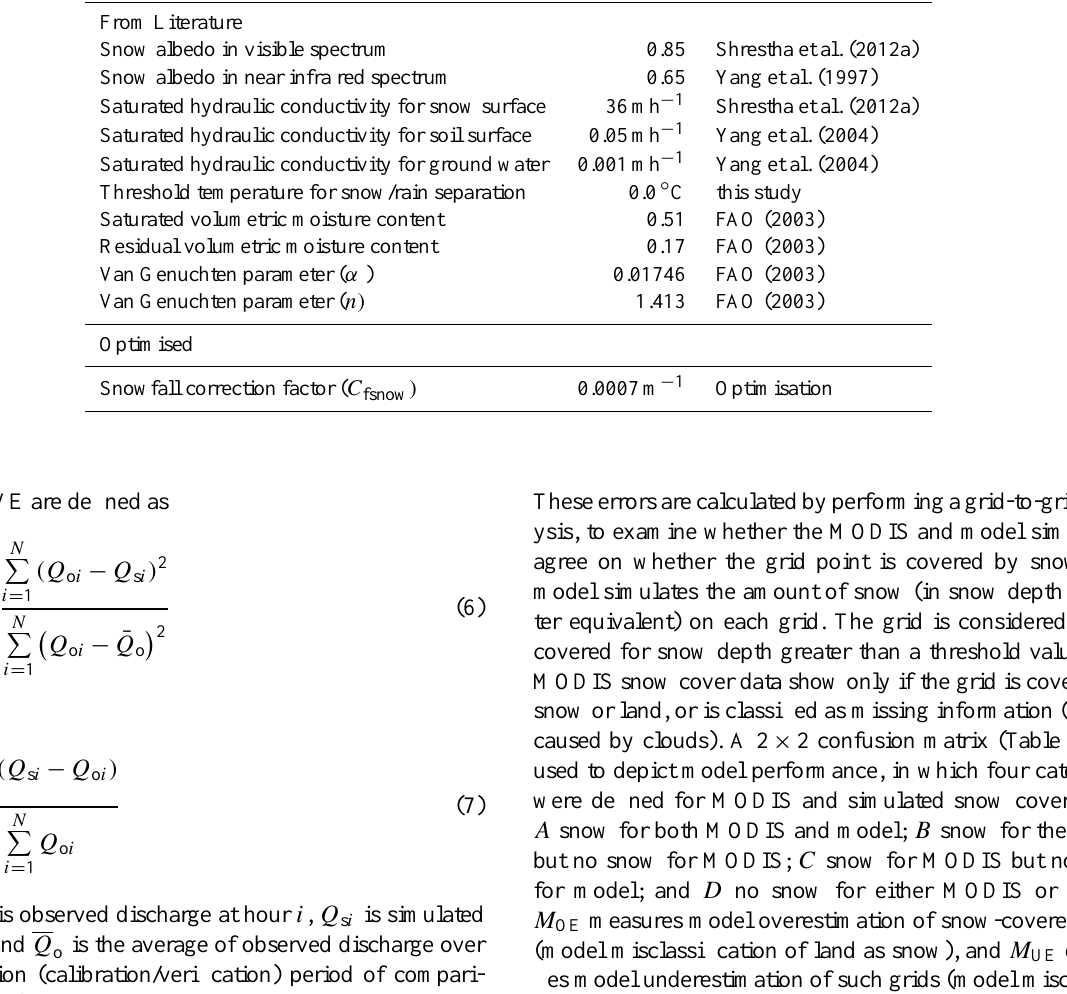
Table 2. Model parameters used. Model